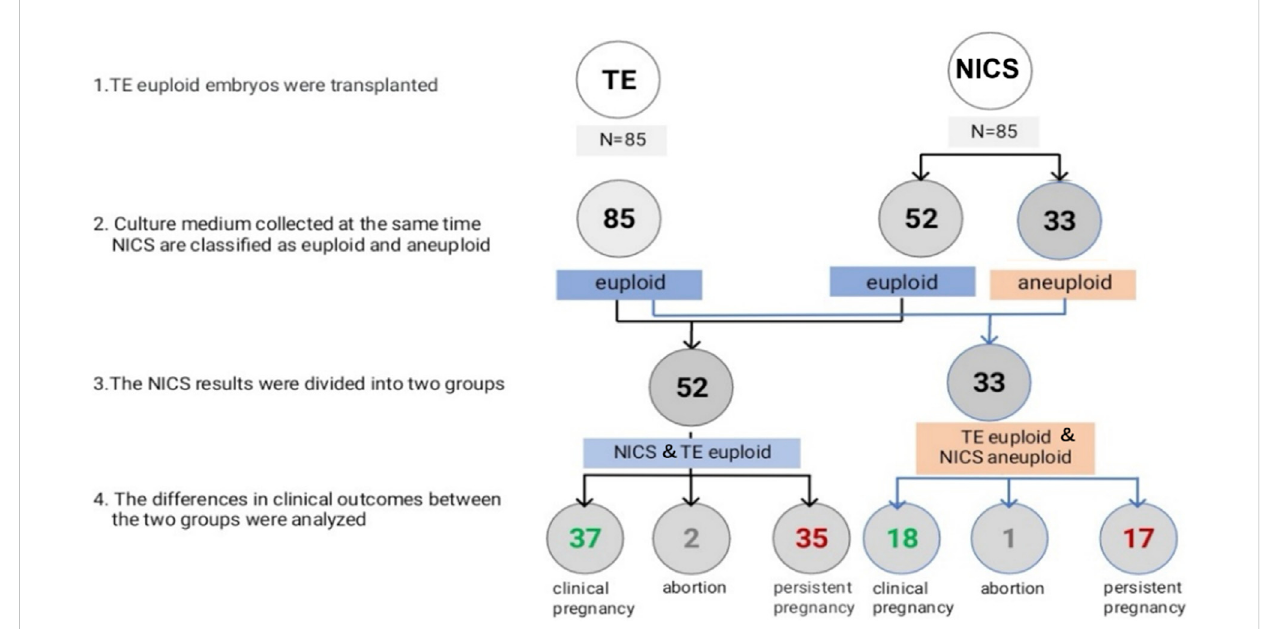
FIGURE 2 Euploidy and clinical outcomes of the transferred embryos. Abbreviations: NICS, non-invasive chromosomal screening; TE, trophocyte.